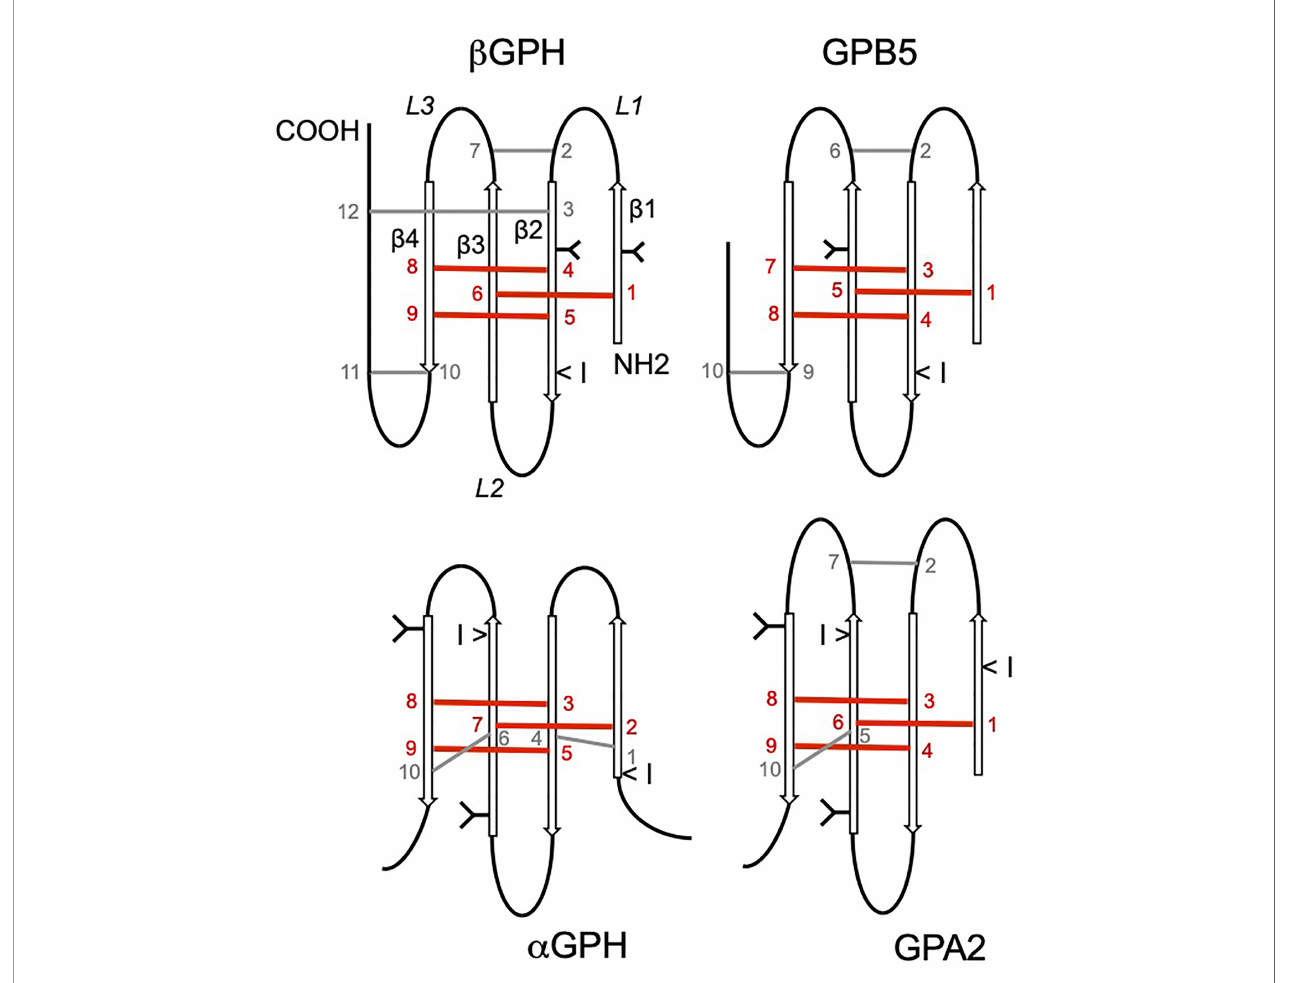
FIGURE 1 | Schematic representation of the glycoprotein hormone (GPH) a - and b subunits and comparison with predicted structure of GPH paralogs GPA2 and GPB5. N -linked glycosylated chains are represented by Y shapes: for GPH b subunits, the fi rst position (from the N-terminal) is common to LH- and FSH b subunits whereas the second one is common to TSH- and FSH b subunits. Location of the conserved intron splicing site is indicated by <I symbol. The conserved cysteine residues are numbered. Disul fi de bonds are represented by bars. Bars and cysteine numbering are given in red when involved in the cystine-knot structure and in grey for the additional ones. Location of the b strands ( b 1 – b 4) and loops ( L1 – L3 ) is